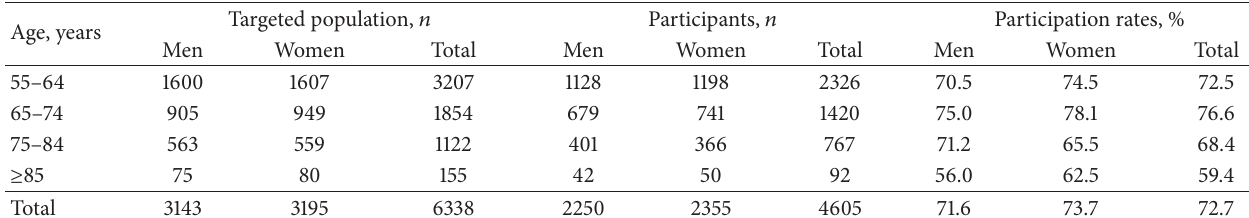
Table 1: Age and sex distribution of the targeted population, participants and participation rates.